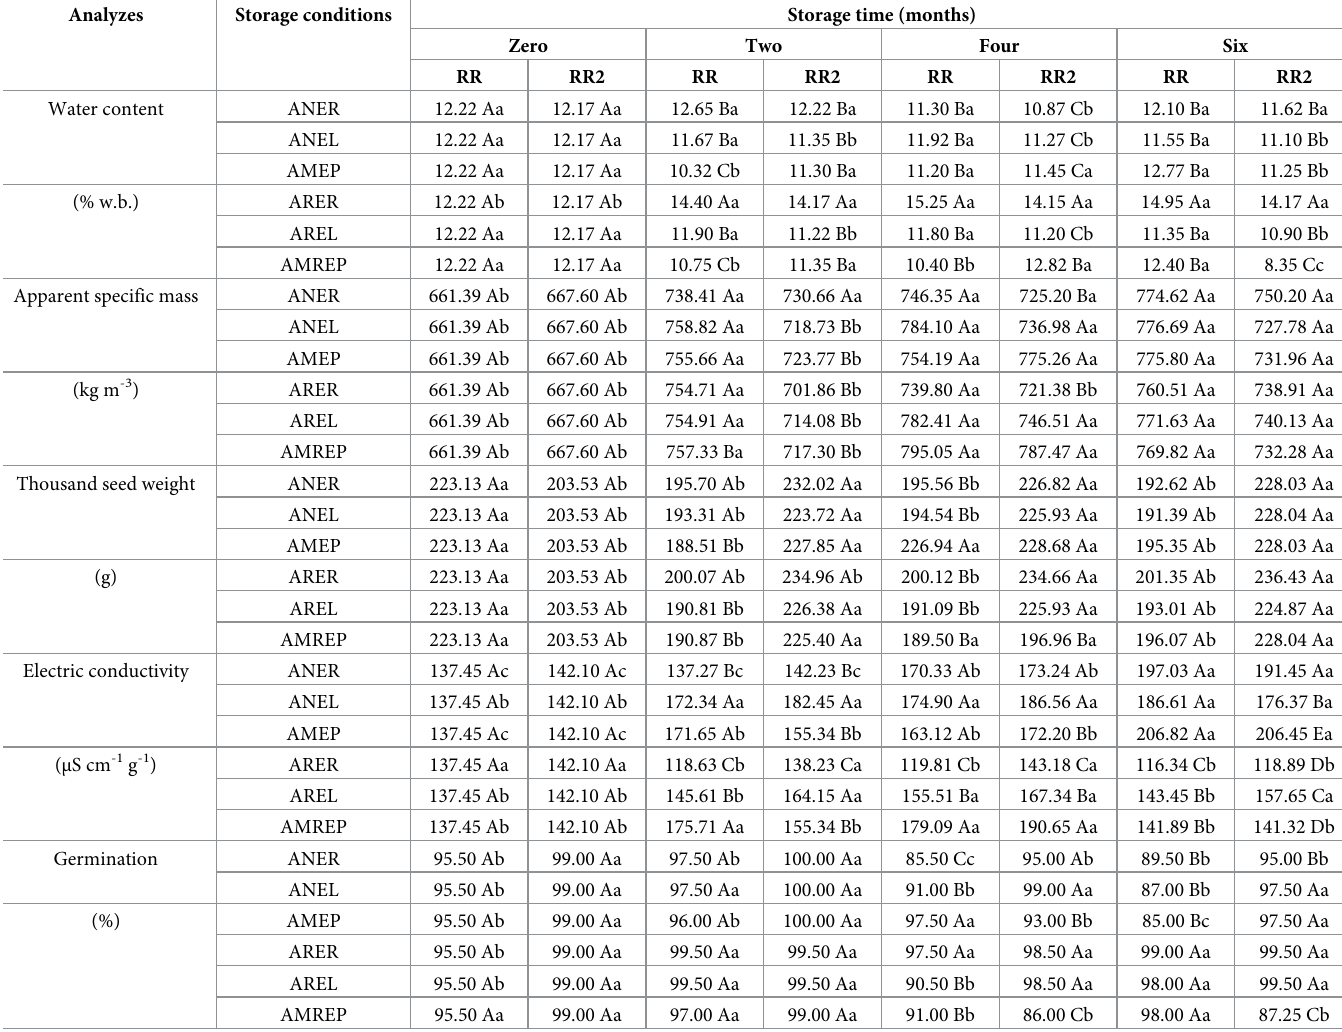
Table 6. Evaluation of the quality of soybean seed cultivars according to the type of packaging, conditions and storage time.